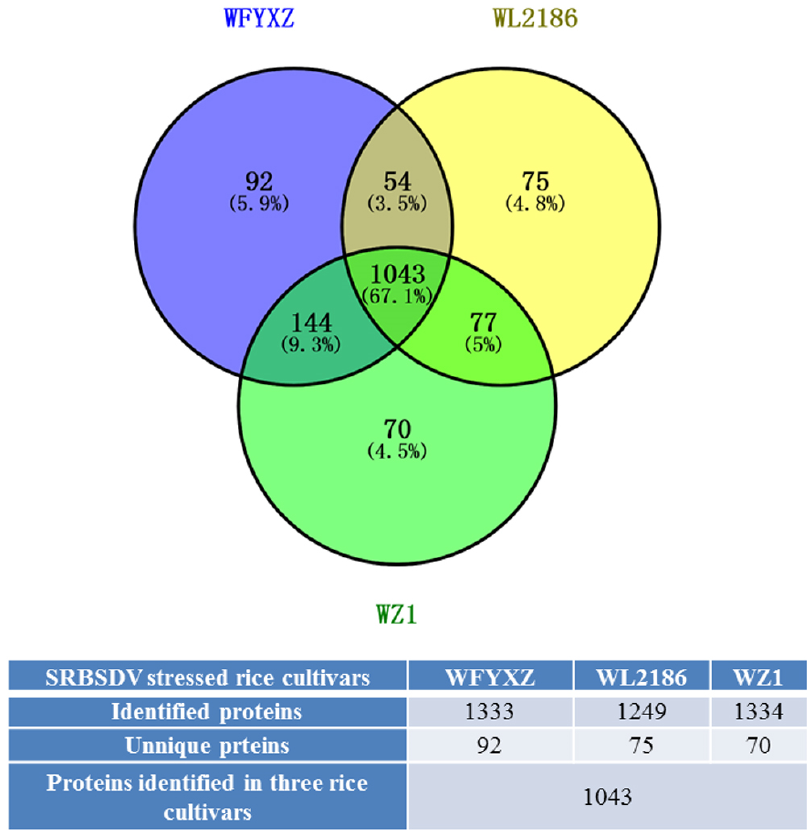
Figure 7. Distribution and overlap of rice proteins identified in SRBSDV ‐ stressed varieties. Blue circle: SRBSDV ‐ stressed FYXZ cultivars (WFYXZ); Yellow circle: SRBSDV ‐ stressed L2186 (WL2186); Green circle: SRBSDV ‐ stressed Z1 (WZ1).